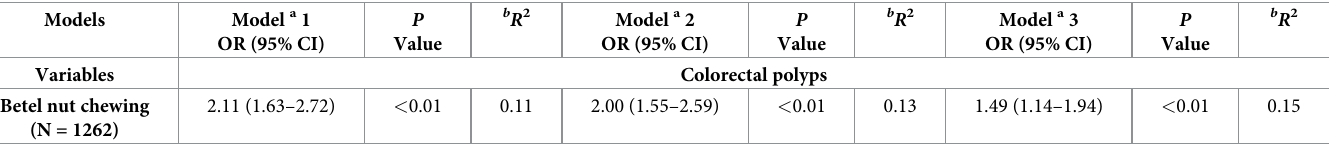
Table 3. Multivariate regression analyses for association between betel nut chewing and the presence of colon polyps.